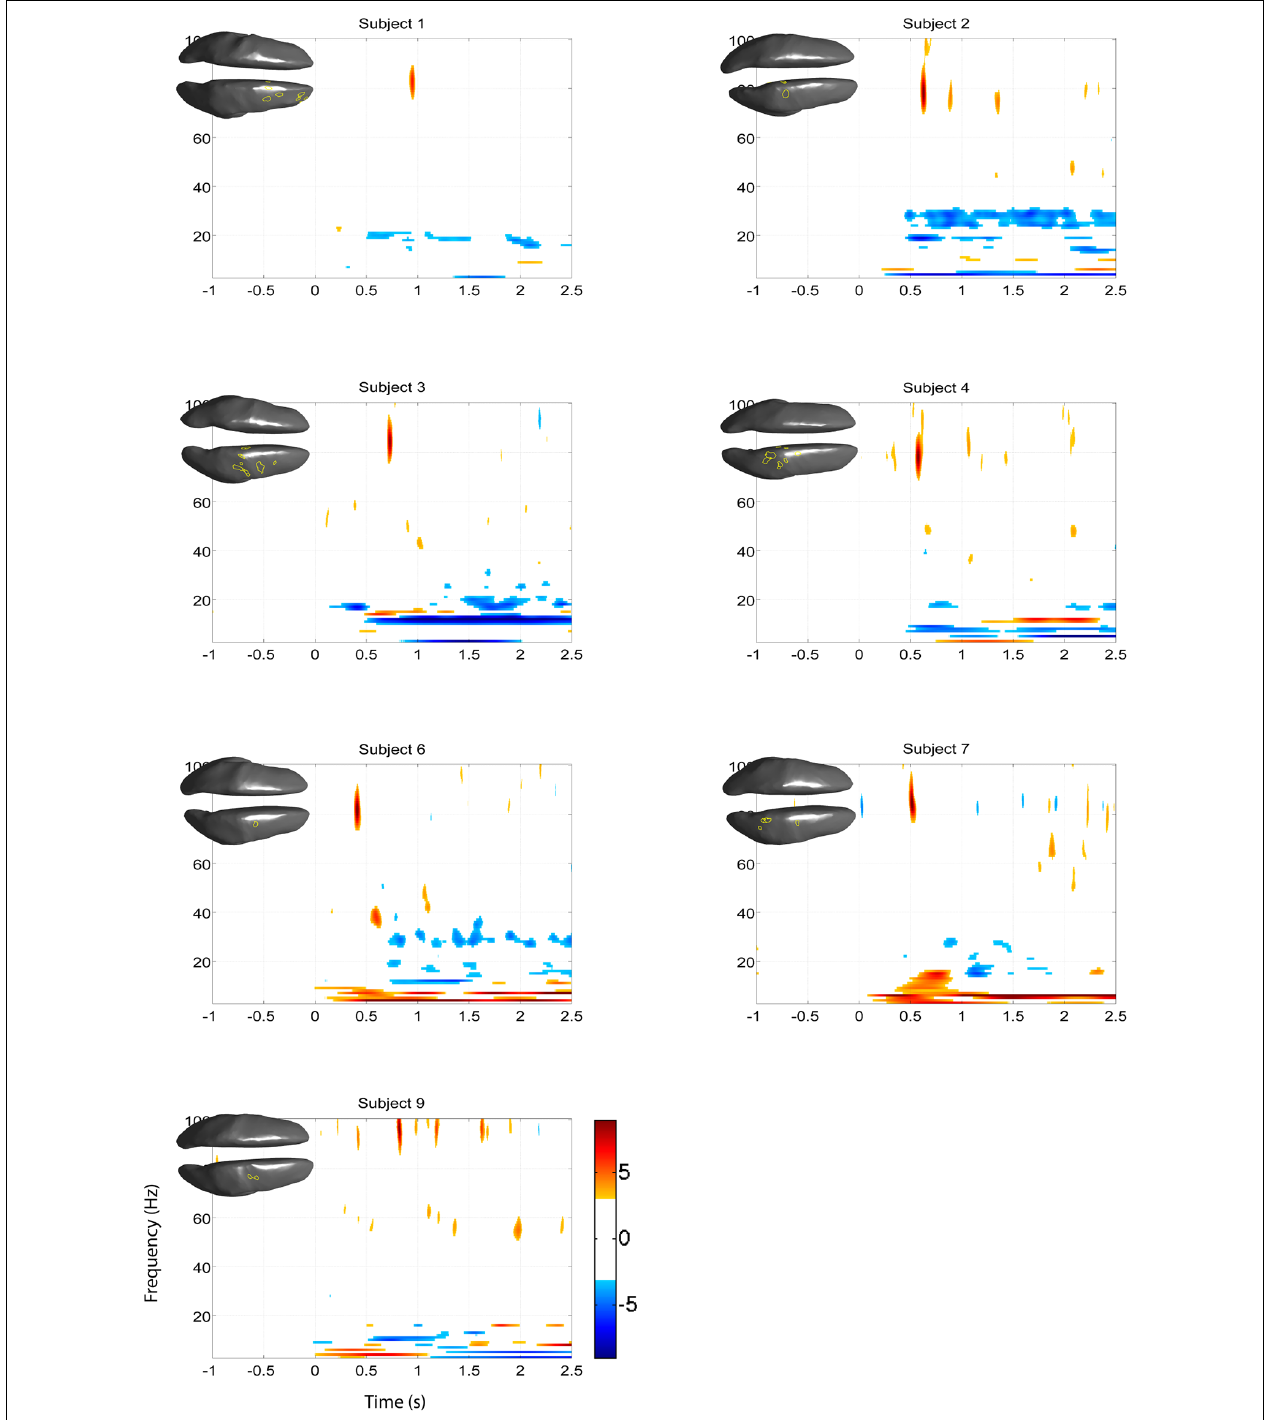
FIGURE 10 | Z -score time-frequency maps during left hand motor imagery of the eight remaining subjects for the cortical regions indicated on the cortical surface displayed in the upper left corner. The maps show that subjects have significant HG increases post-cue in a narrow band.